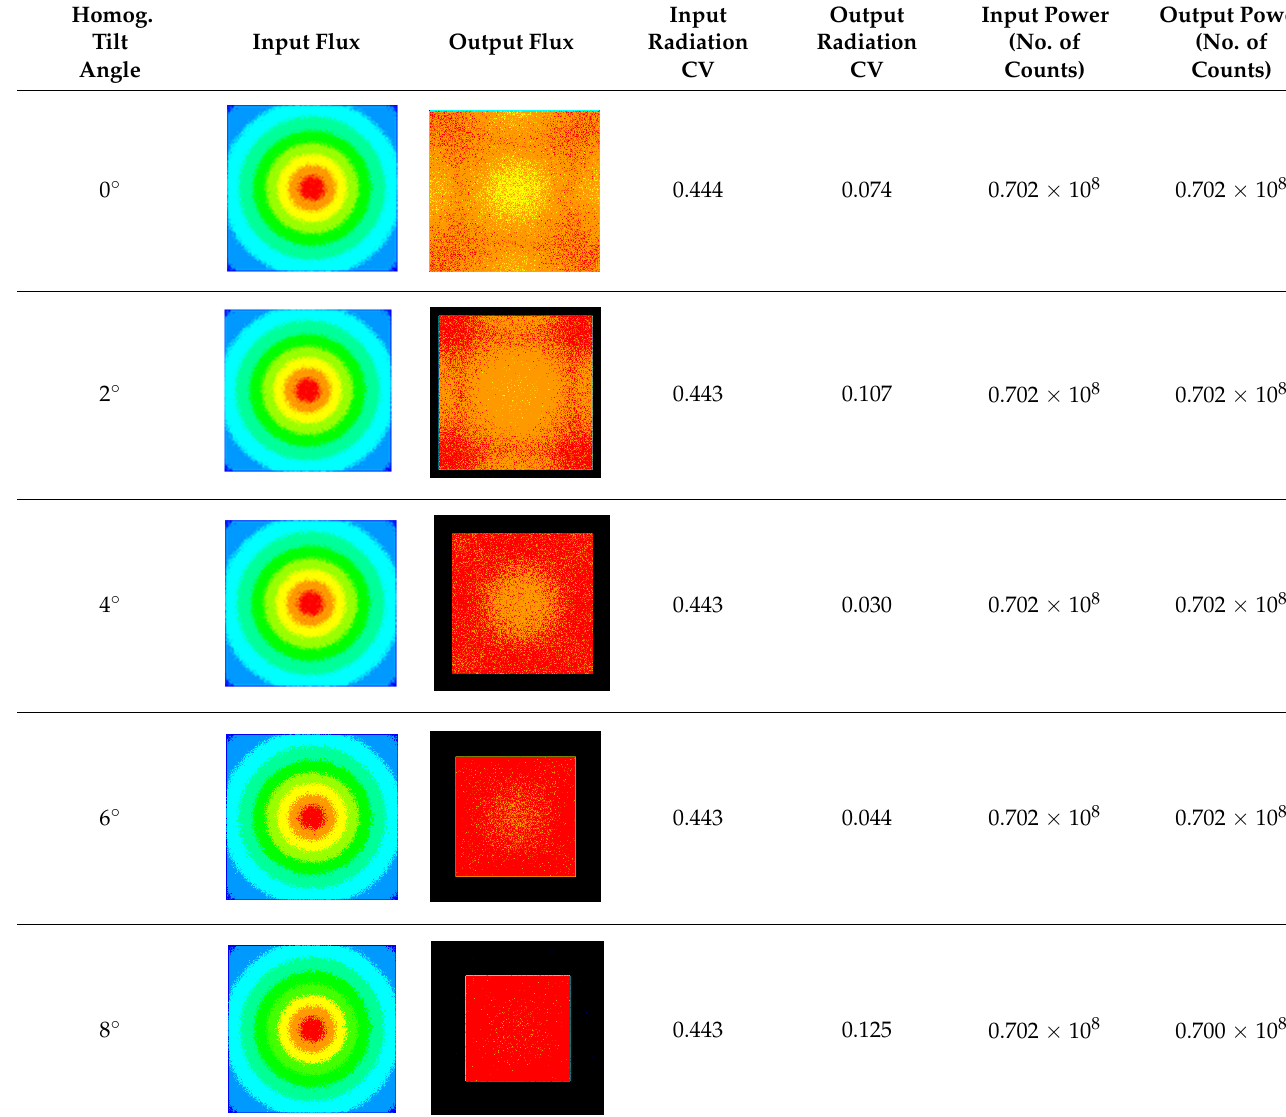
Table 7. Radiation flux, CV, and power at homogenizer entrance and exit, as a function of the tilt angle, for the following conditions: Number of faces = 4; total length = 350 mm, position = 0 (centered at the theoretical focal point).